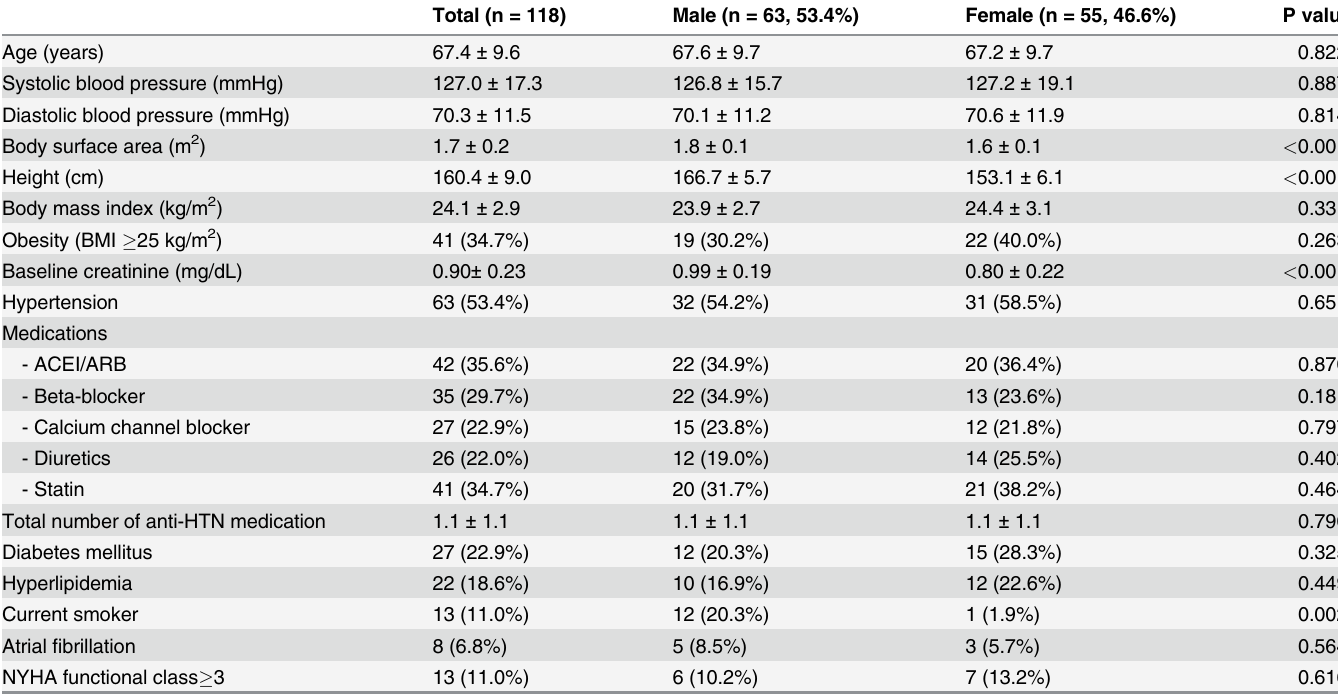
Table 1. Baseline clinical characteristics of the study